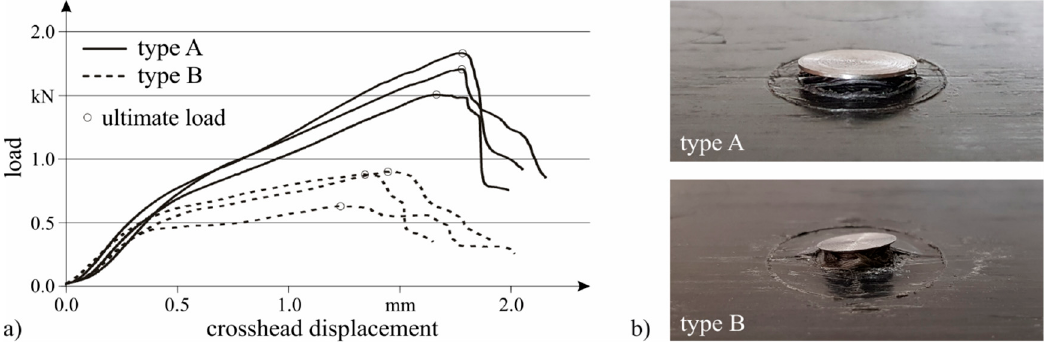
Figure 7. Results of the push-out tests: ( a ) load-displacement curves, ( b ) typical failure behaviour.